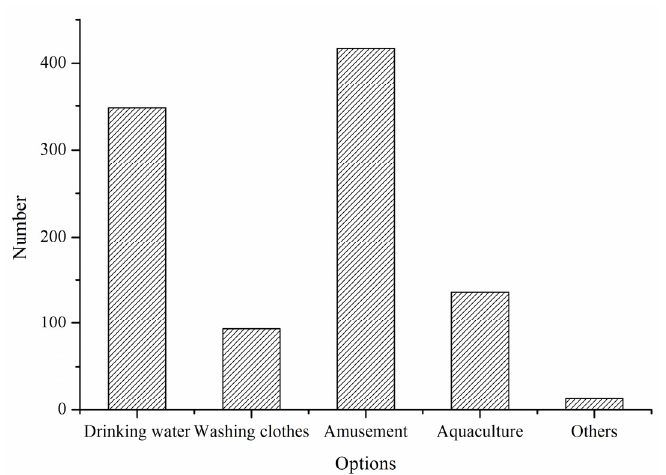
Figure 3. Frequencies of utilization of functions and